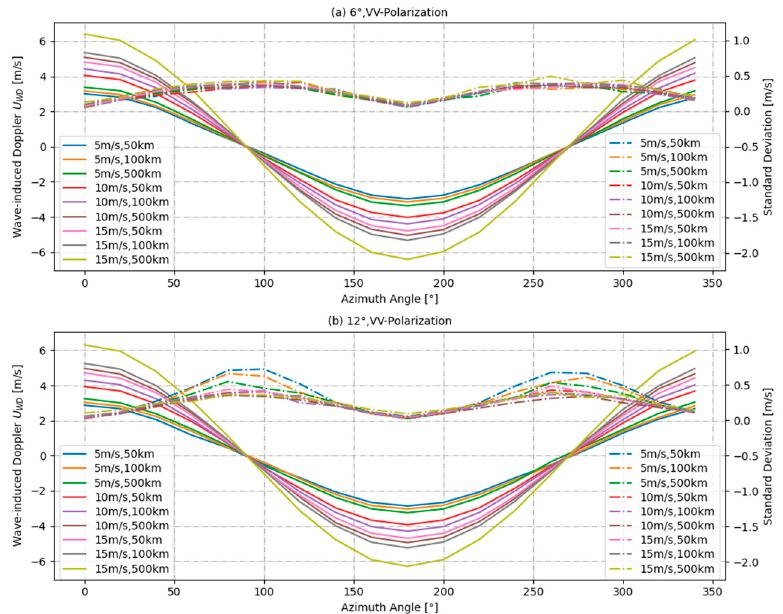
Figure 14. Variation in U WD and standard deviation with radar azimuth for 5, 10, and 15 m/s wind speeds corresponding to different wind fetches (50 km, 100 km, and 500 km), with radar incidence angles of 6° and 12°, wind direction of 0°, and no swell. The y-axis on the left refers to U WD values, which are shown in colored solid lines. The y-axis on the right refers to U WD standard deviations, which are shown in colored dashed lines.